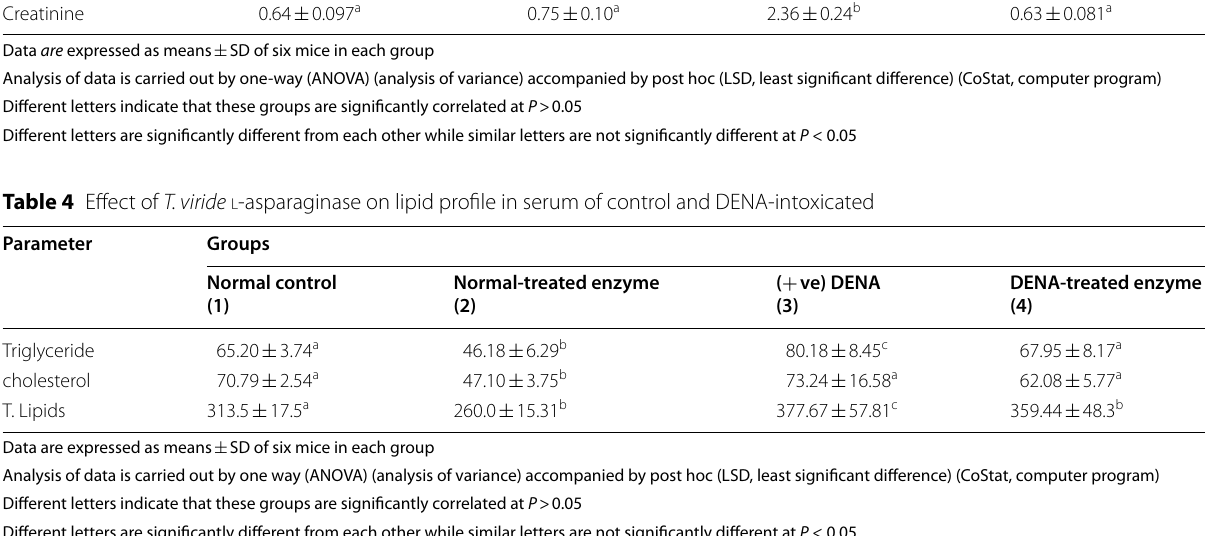
Data are expressed as means SD of six mice in each group ± Analysis of data is carried out by one way (ANOVA) (analysis of variance) accompanied by post hoc (LSD, least significant difference) (CoStat, computer program) Different letters indicate that these groups are significantly correlated at P > 0.05 Different letters are significantly different from each other while similar letters are not significantly different at P < 0.05